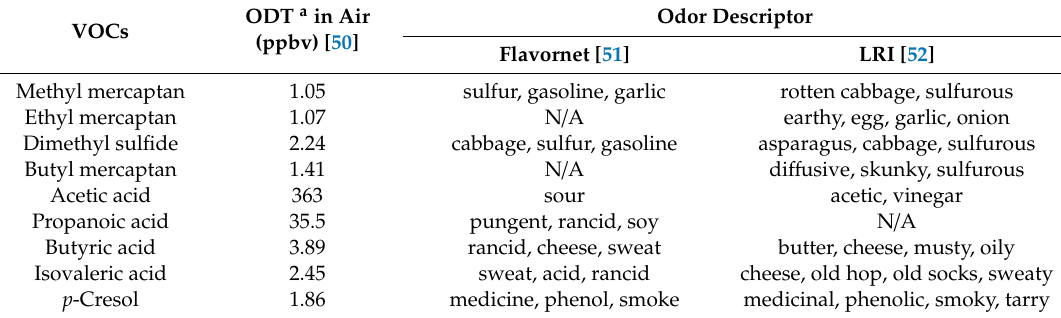
Table 3. Odor characteristics of target odorous VOCs used to prepare a synthetic air mixture.